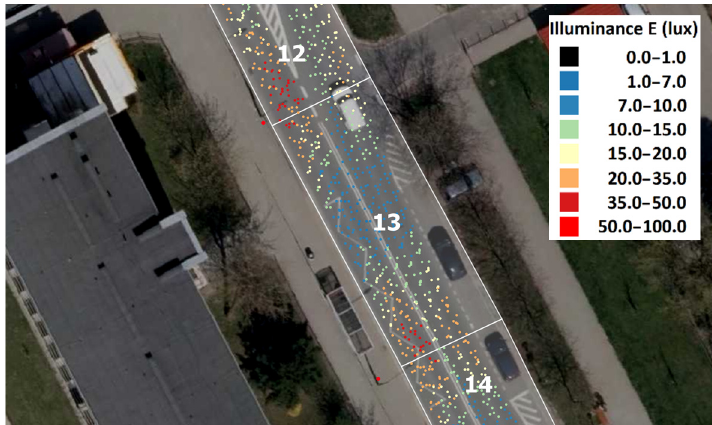
Figure A8. Example of five illuminance measurements in field No. 13.